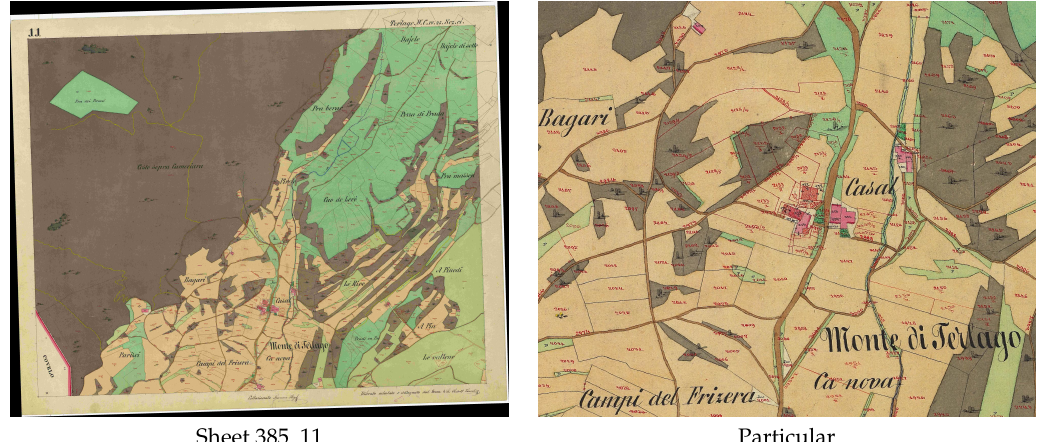
Figure 1. Map sheet 385_11 (“Comune catastale di Terlago”) of the Historical Cadaster Map of the Province of